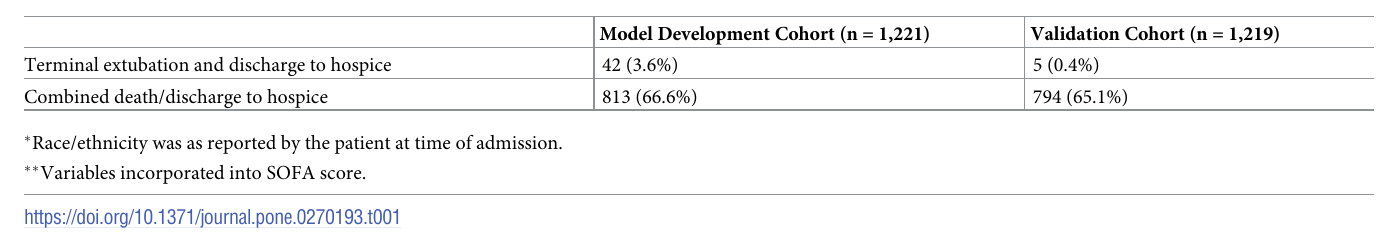
Table 2. Multiple logistic regression model with significant predictor variables for the outcome mortality in the model-development cohort. Significant predictor variables in the C-TIME MLR model: Odds ratio � (95% CI) P value